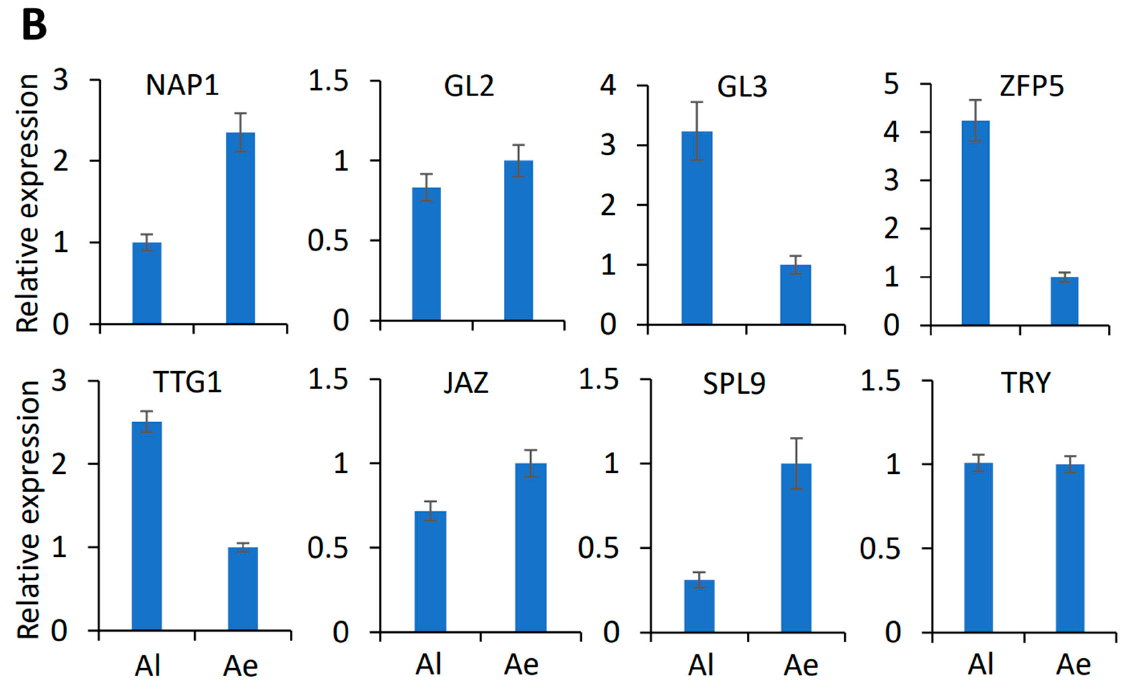
Figure 3. The expression levels and qRT − PCR veri fi cation of trichome-regulating genes in Al and Ae. ( A ) The expression levels of positive and negative regulators of trichome development in three replicates of RNA sequencing. ( B ) qRT − PCR analysis of these genes in Al and Ae. The relative expression levels are shown in the mean values ± SD from three biological replicates.